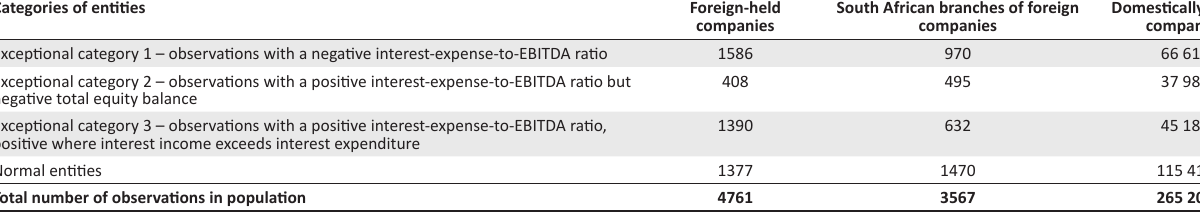
TABLE 2: Breakdown of population to describe interest-to-EBITDA ratios. Categories of